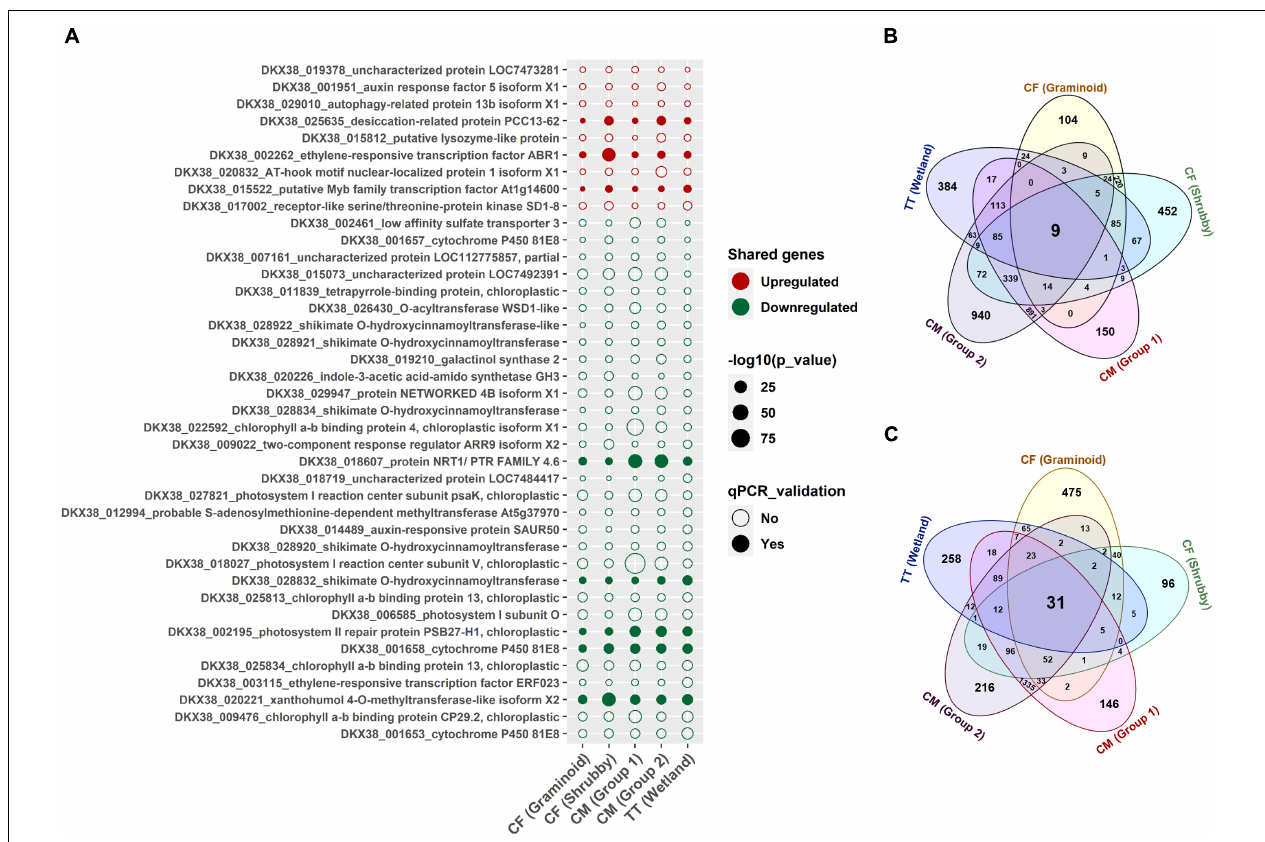
FIGURE 5 | Shared and group specific differentially expressed genes (DEGs) in willow grown in different types of oil sands tailings with no reclamation cap or 5 cm of reclamation cap (treatments) compared with ≥ 30 cm of reclamation cap (controls). Functions and locus tags of genes which are shared among all groups are shown in dot plot (A) . Numbers of significantly upregulated genes that are shared and unique in each group (B) and numbers of significantly downregulated genes that are shared and unique in each group (C) are shown in Venn diagrams. Only genes with BH-adjusted p -values < 0.05 and log 2 fold change > 2 in each group were considered significantly deregulated and the dot size corresponds to the − log10 p -value. Genes validated with qPCR are highlighted by filled dots. CF, centrifuge tailings; CM, co-mix tailings; TT, thickened